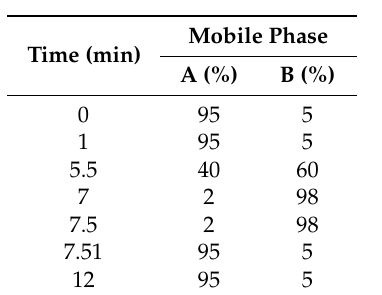
Table 5. Gradient program for HPLC separation of C118P and